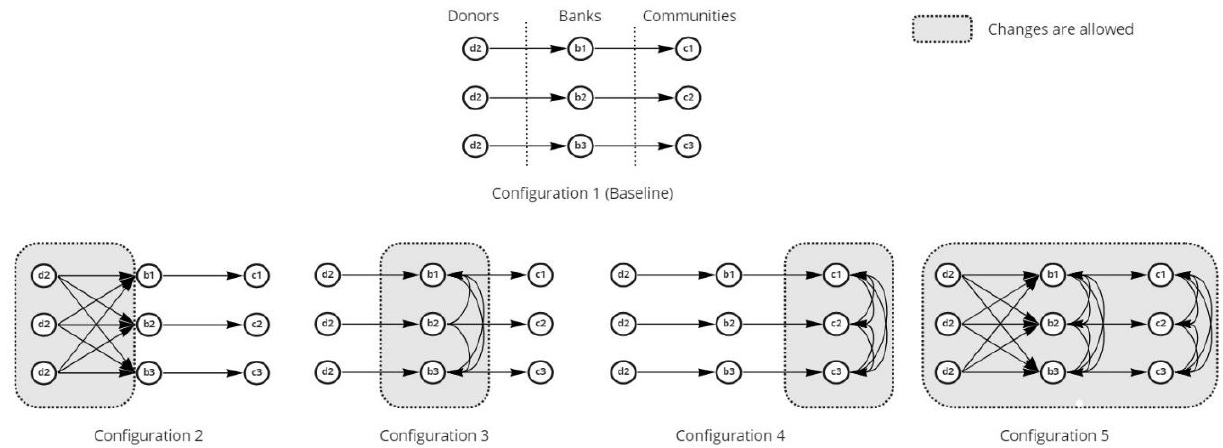
Figure 3. Considered reconfiguration alternatives. The gray boxes identify the part of the network in which changes are allowed, with respect to the day-to-day solution.